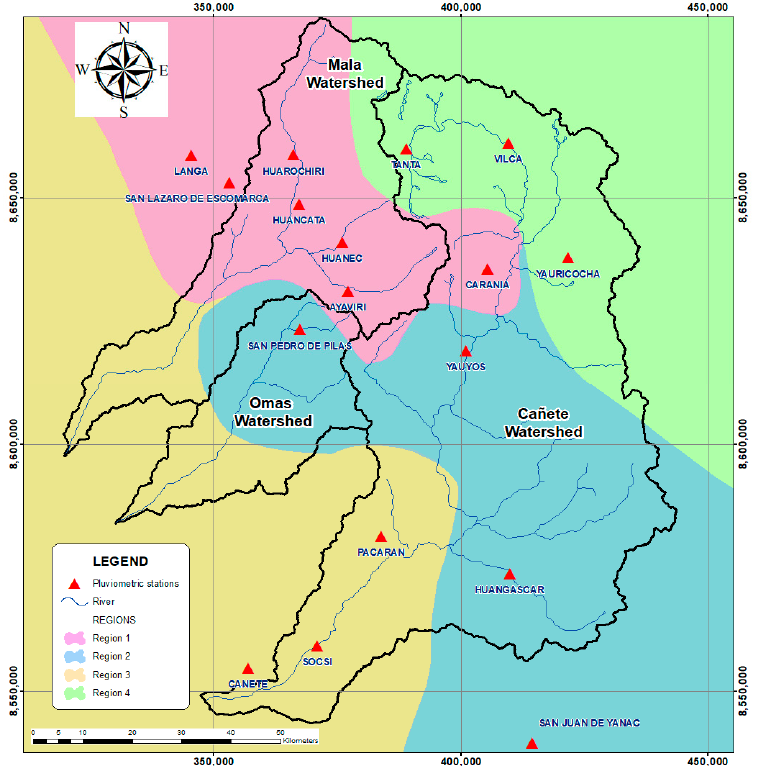
Figure 10. Regionalization of the stations according to the KM and MVR methods.